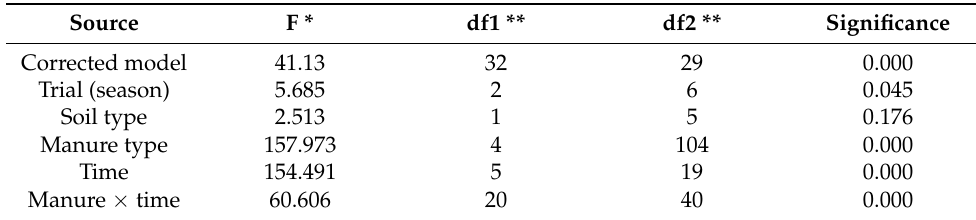
Table 3. Analysis of treatment effects on E. coli populations in manure-amended